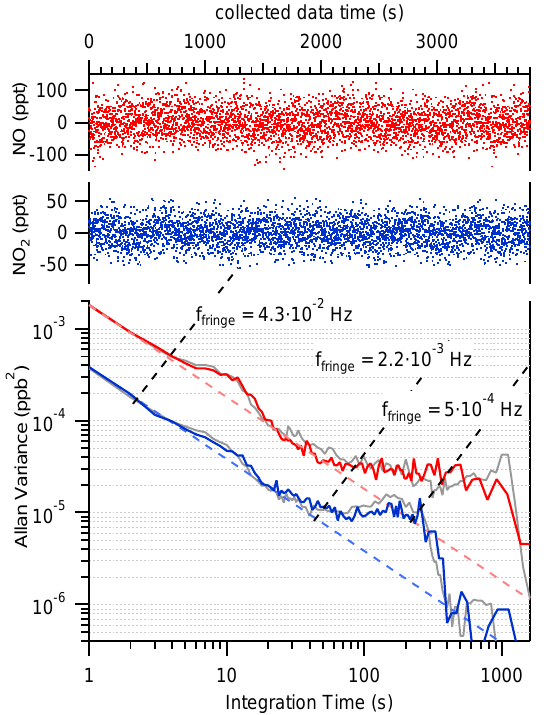
Fig. 2. Allan variance plots for NO and NO 2 measured with the dual-laser instrument at the Jungfraujoch using NO x -free air as gas sample. The gray lines correspond to calculated white noise plus fringes ( f fringe ) contributing as flicker noise (details in text).